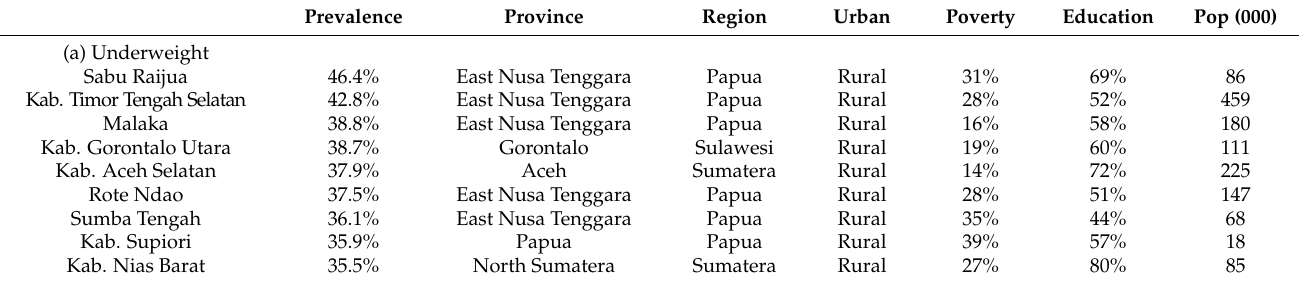
Table 4. Ten districts with the HIGHEST prevalence of child undernutrition in Indonesia,